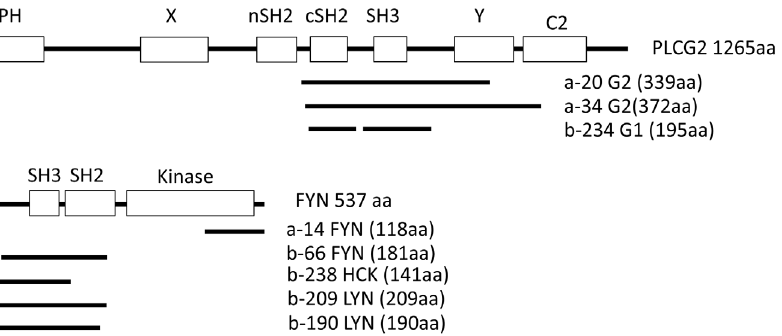
Figure 1. Clones belonging to the phosphoinositide-specific phospholipase C and the family of Src kinases isolated in two yeast two-hybrid screens. (A) Representation of PLCg2 modular structure and the coding region of the clones identified in the Y2H. Clones named a- correspond to the first screen using as bait the full-length BANK1, clones starting with b- are the ones identified in the screen with the non autoactivating truncated protein BANK1 (331–785). The clone b-234 has a deletion of 25 aa between the cSH2 and SH3 domains. (B) Structure of the Src kinase FYN and the isolated clones belonging to this family of non- receptor kinase. PH: Pleckstrin homology domain, involved in the recruitment to membranes by binding to phosphatidylinositol containing lipids. X and Y are the two halves of the catalytic isomerase. SH2 (Src homology 2) conserved domain that typically binds to phosphorylated tyrosine residues. SH3 (Src homology 3) usually binds to proline-rich motifs. The C2 motif is present in many proteins that interact with membranes and are frequently involved in calcium dependent phospholipid binding and membrane